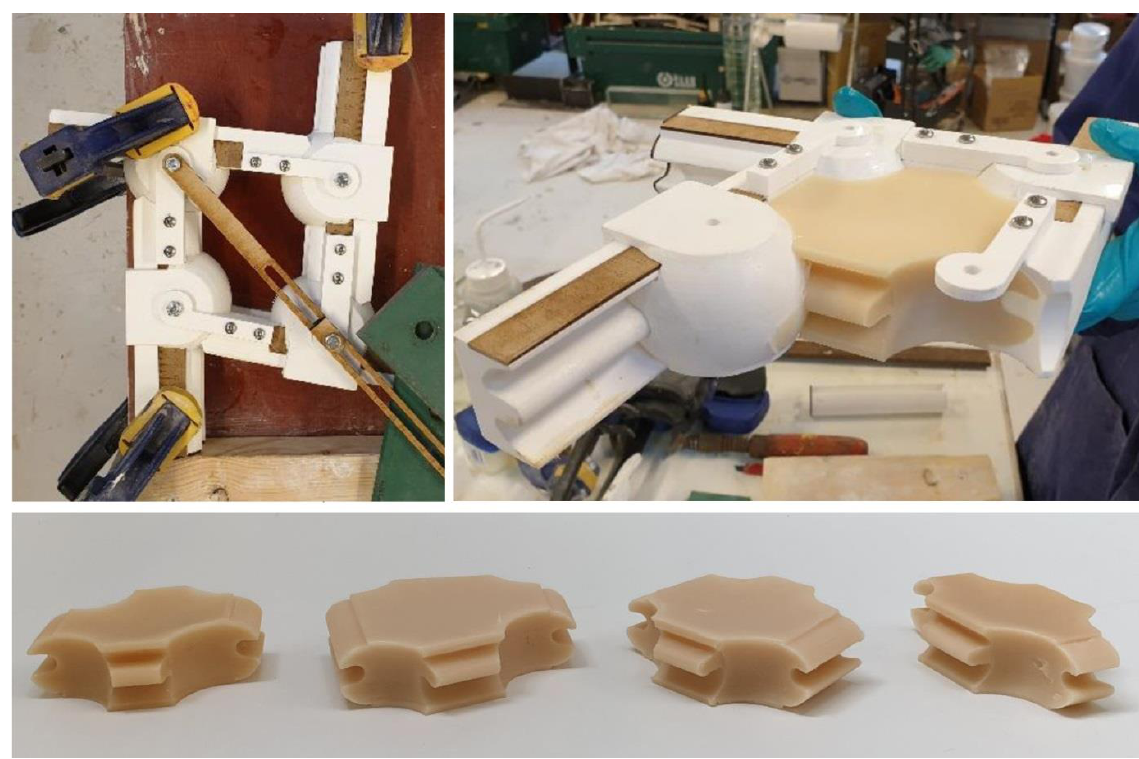
Fig. 17 Top: Set-up of the adhstable mould for wax prototype. Bottom: Cast was prototypes of different sizes produced by the same